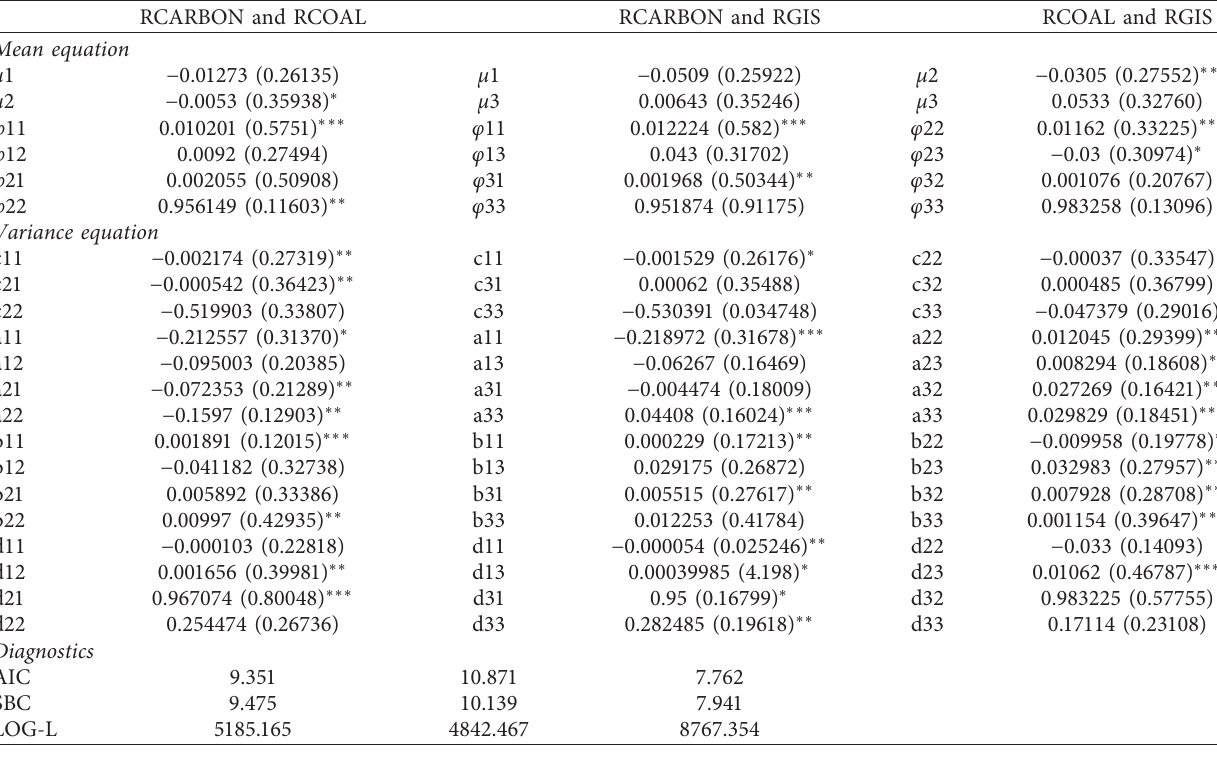
Table 9: Result of